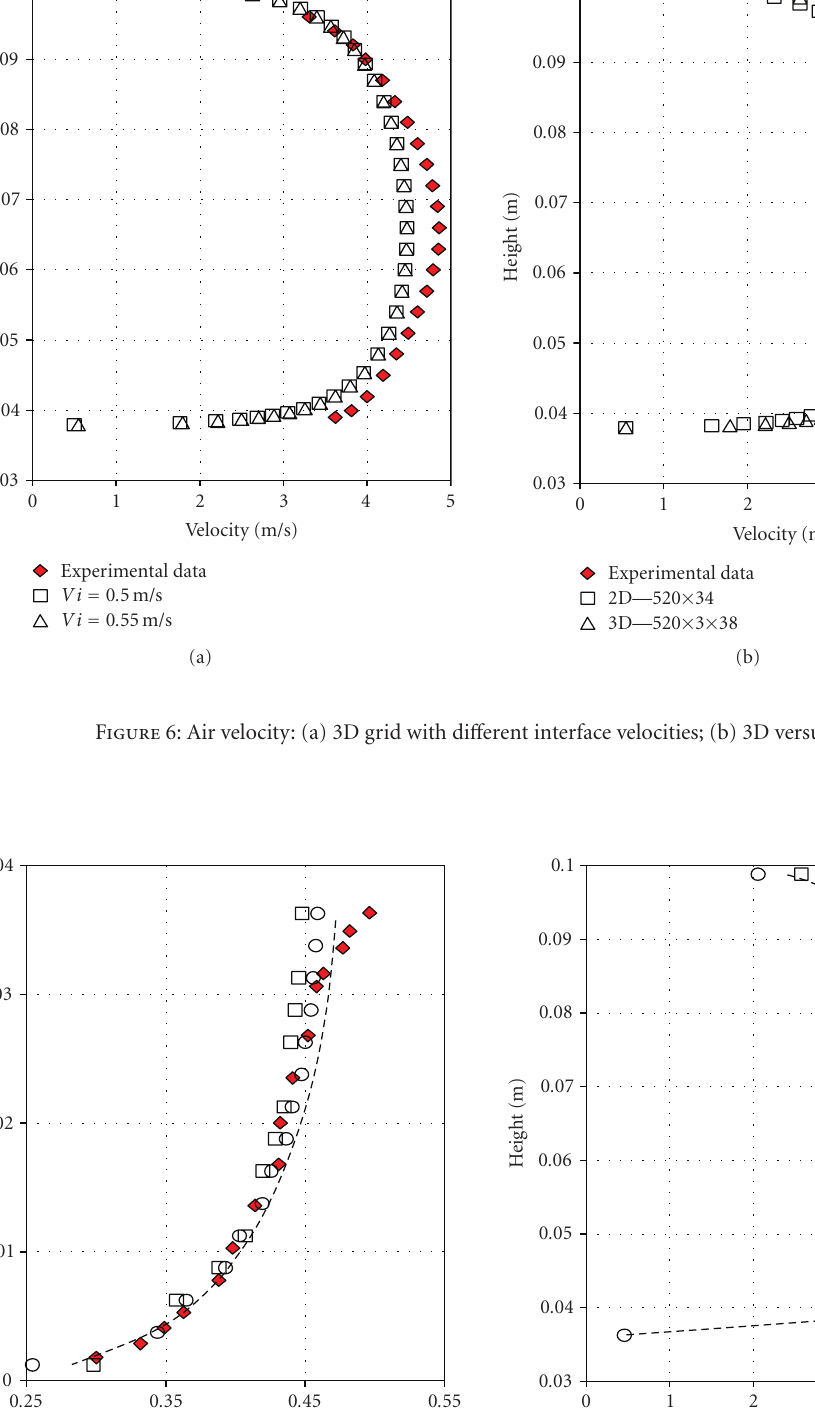
0 . 550 . 450 . 350 . 25